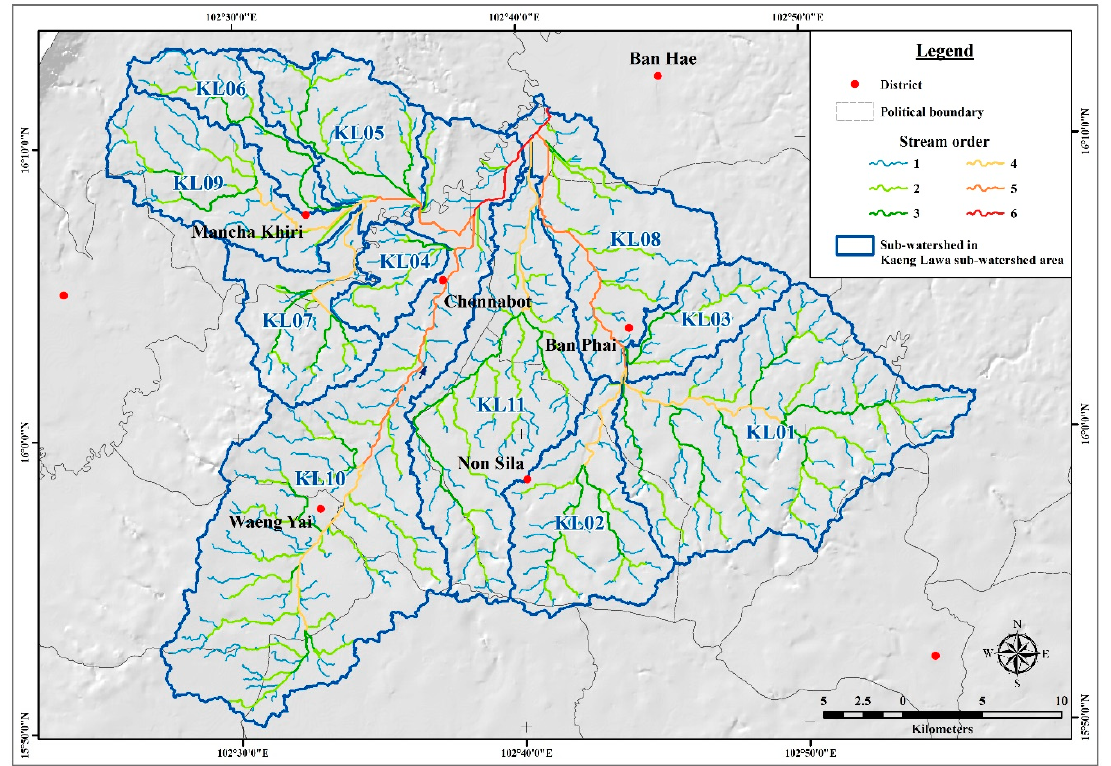
Figure 4. Map of drainage and ranking based on Strahler [ 32 ] .